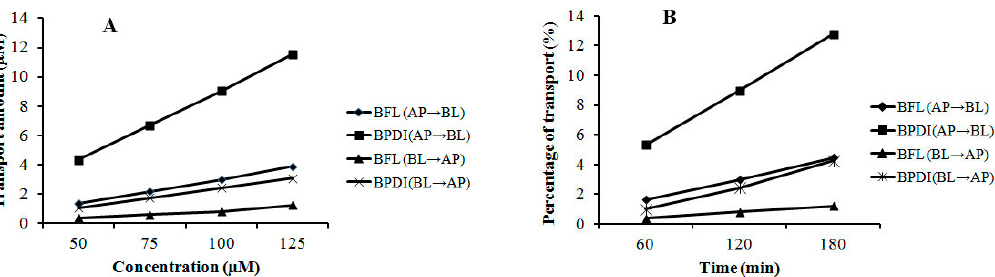
Figure 2. Transports of BFL and BPDI across Caco-2 cell monolayer. ( A ) The transport amounts at 120 min with different concentrations ( n = 3); ( B ) The percentages of transports in different time points with a concentration of 75 μ M ( n = 3).